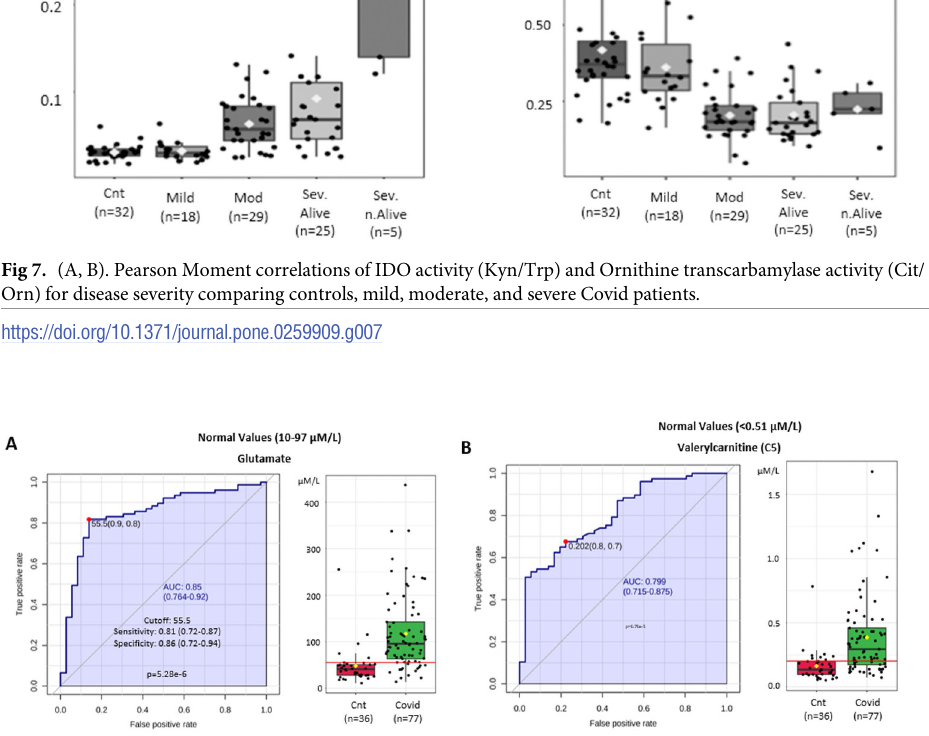
Fig 8. (A, B). Glutamate and Valeryl-carnitine (C5) concentrations comparing controls (red) n = 36 to Covid 19 patients (green) n = 77 provide ROC AUC = 0.85 (95% CI 0.764–0.92) and AUC = 0.799 (95% CI 0.715–0.875)